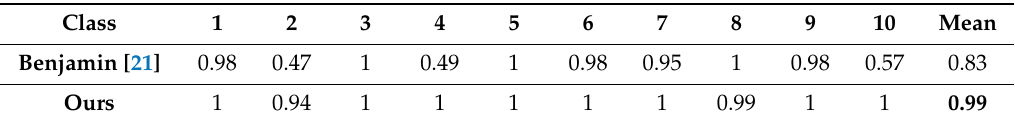
Table 3. Area under the receiver-operating characteristic (AUC-ROC) curve performance comparison, higher mean is